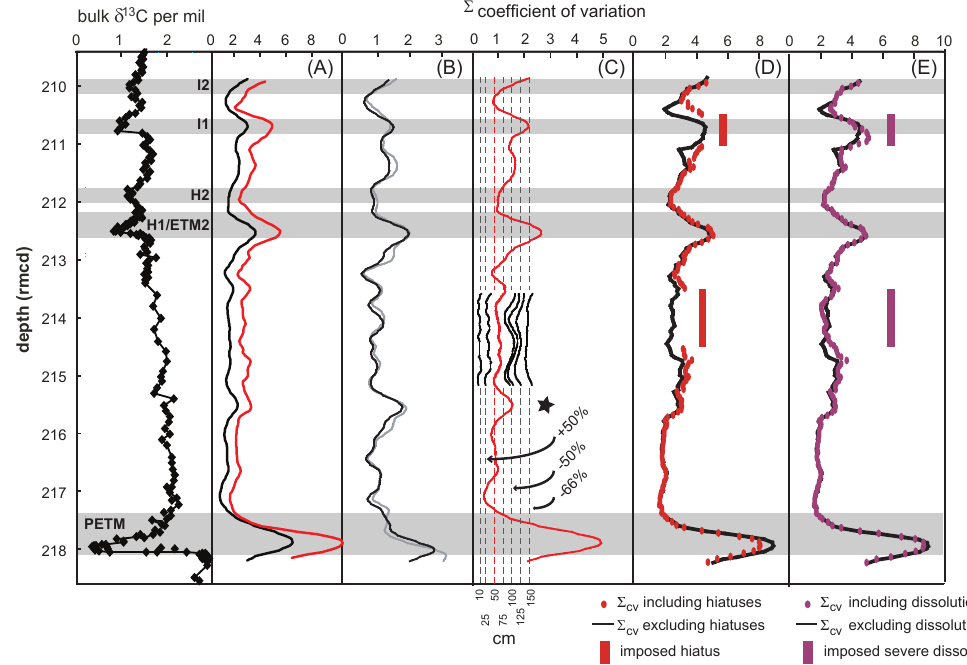
Fig. 3. Sensitivity tests and comparison of downcore summed coefficients of variation (CV) records calculated using smoothed and original raw percent abundance data. Panel (A) shows 6 cv records from smoothed and raw data. Panel (B) is a comparison of total summed CVs of the smoothed data using CVs divided by the taxon’s average across 50cm (grey line) and 100cm windows (black line), whereas in Panel (A) the CVs are divided by the taxon’s average abundance across the entire interval. Panel (C) is a comparison of background 6 cv values that result from different window sizes, extrapolated as vertical dashed lines; the 50cm background 6 cv level is highlighted in red. Also marked is the sedimentation rate change equivalent (in percent) to which these background levels correspond. Panels (D) and (E) show the results of artificially introduced hiatuses and intervals of intense dissolution, respectively. The star indicates the levels of a possible natural hiatus. The original 6 cv record is shown in black and the records that include imposed hiatuses and dissolution are shown in red and purple, respectively. Red and purple vertical bars highlight the intervals where hiatuses and dissolution have been